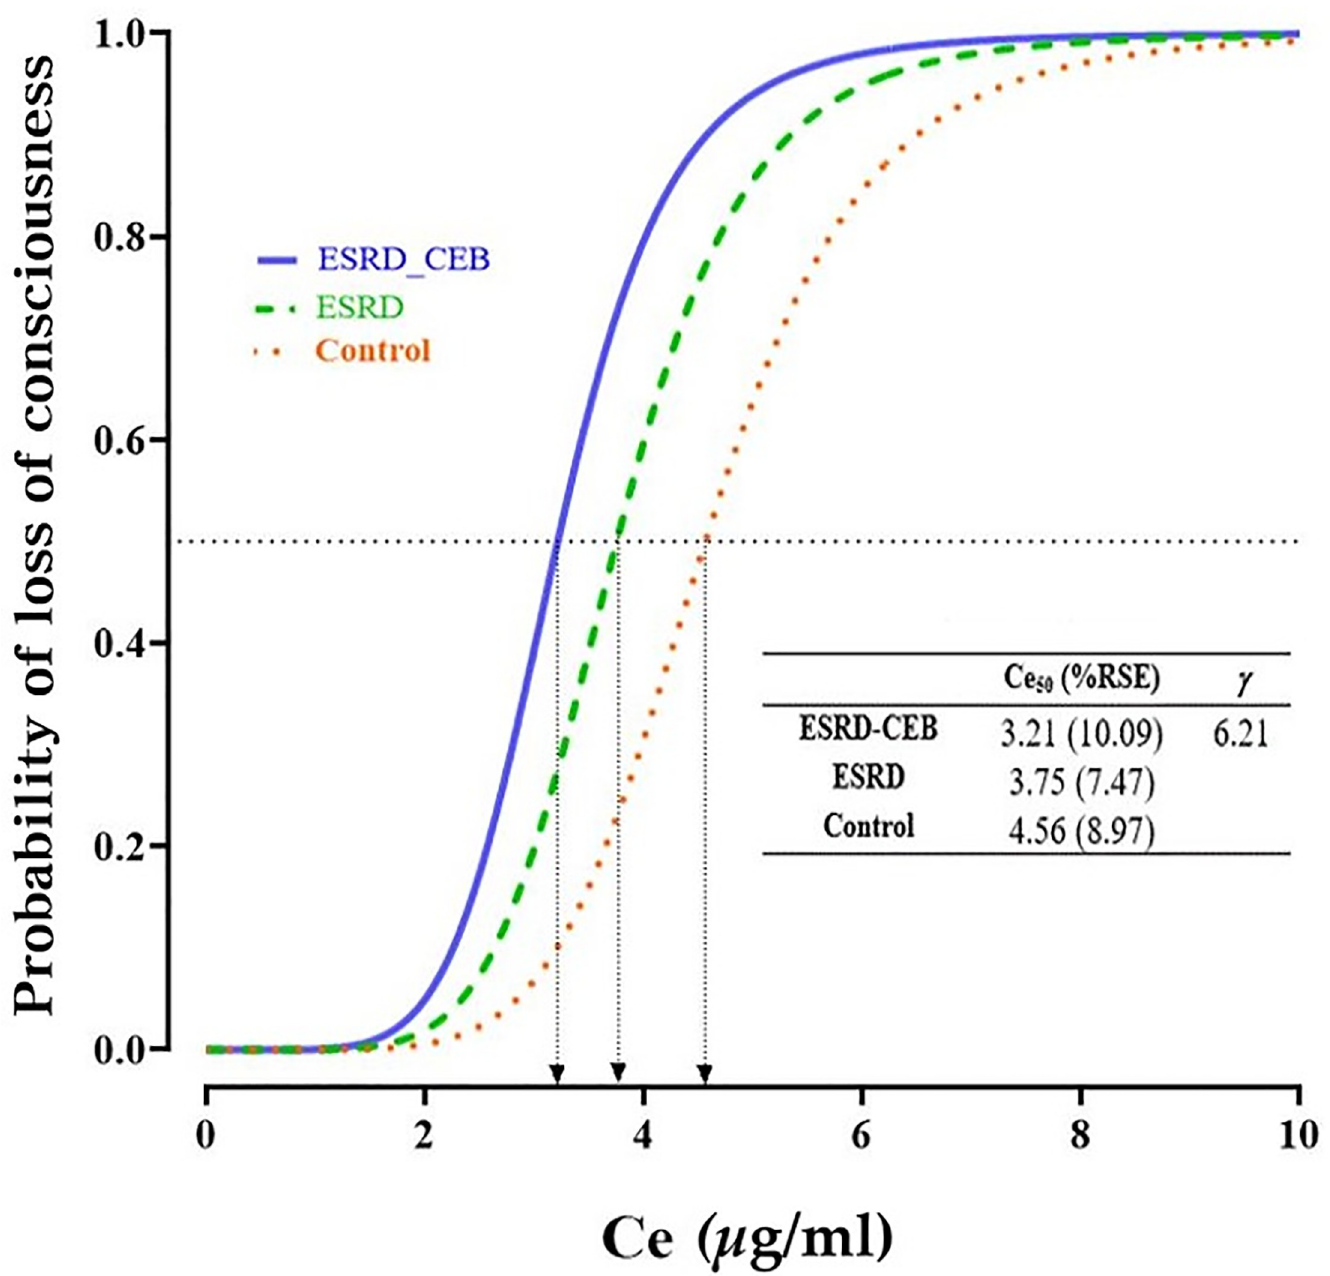
Fig 2. Relationship between the probability of LOC and the Ce of propofol at each study groups. Ce 50 , effect-site concentration associated with a 50% probability of LOC; ESRD, end stage renal disease; LOC, loss of consciousness; CEB, cervical epidural block; γ , steepness of the concentration versus response relationship; RSE, relative standard